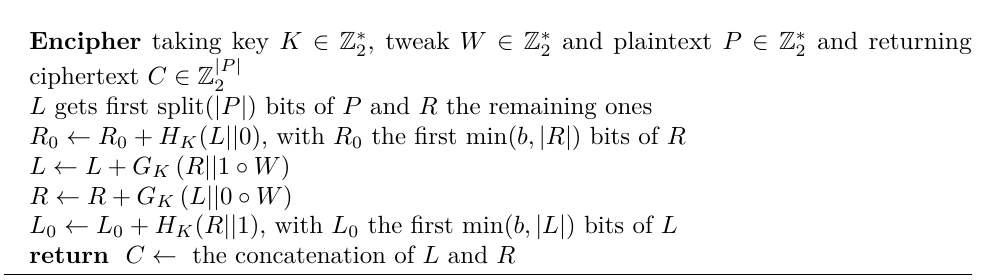
Algorithm 6 Definition of Farfalle-WBC-AE[ H, G, t, ‘ ] Parameters: two PRFs H and G , the expansion length t ∈ N and alignment